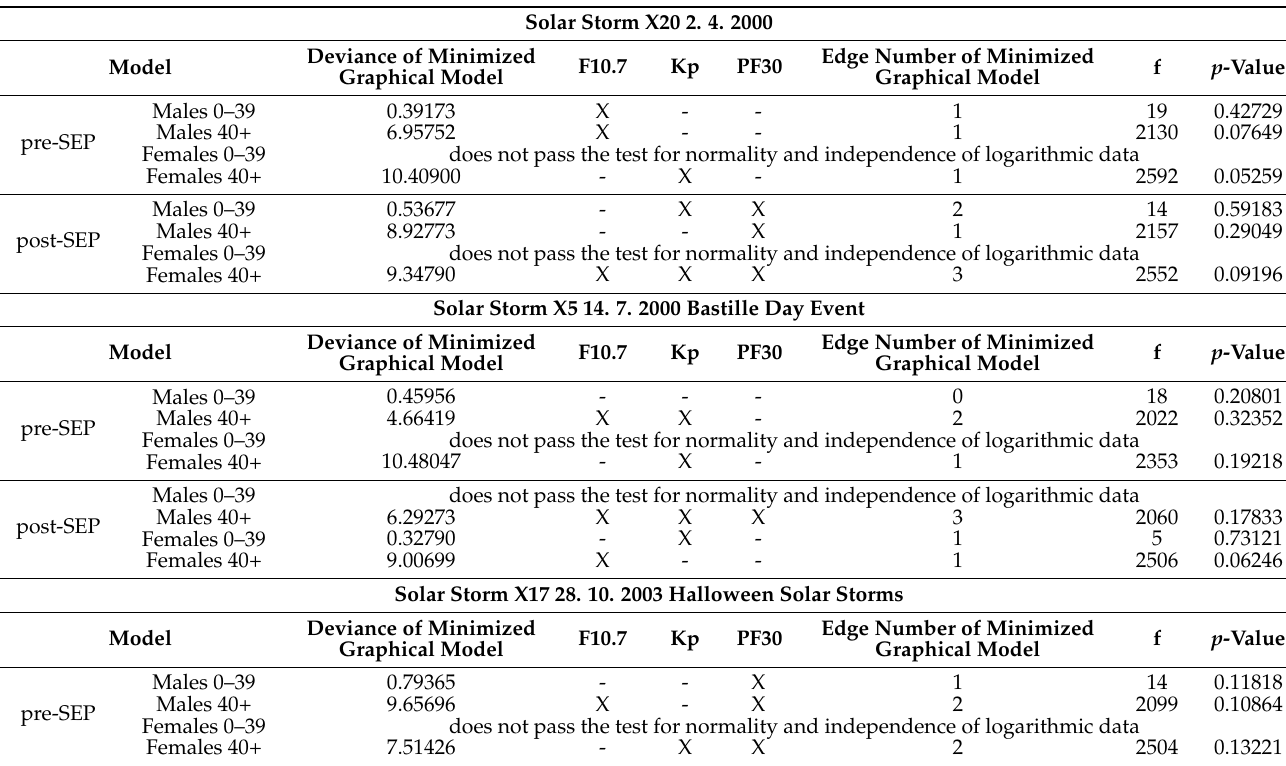
Table 1. Summary of conditional independence graphs (CIG) model computation, diseases of the circulatory system